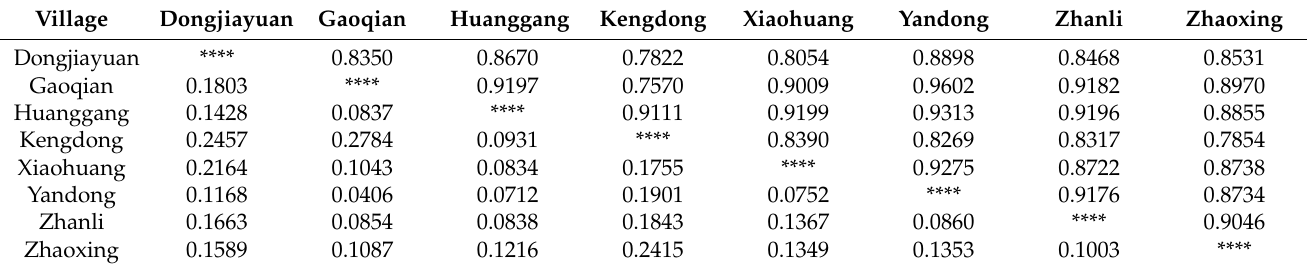
Table 3. The genetic distance and similarity of Kam fragrant glutinous rice among different Dong villages. Village